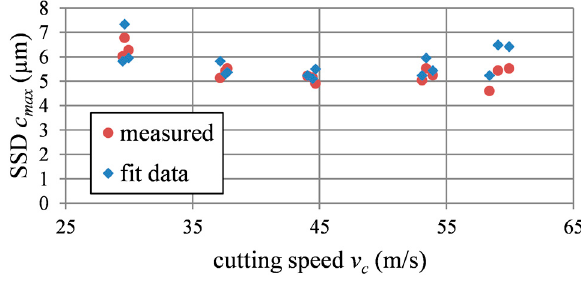
Figure 12. Measured and calculated maximum crack depths.